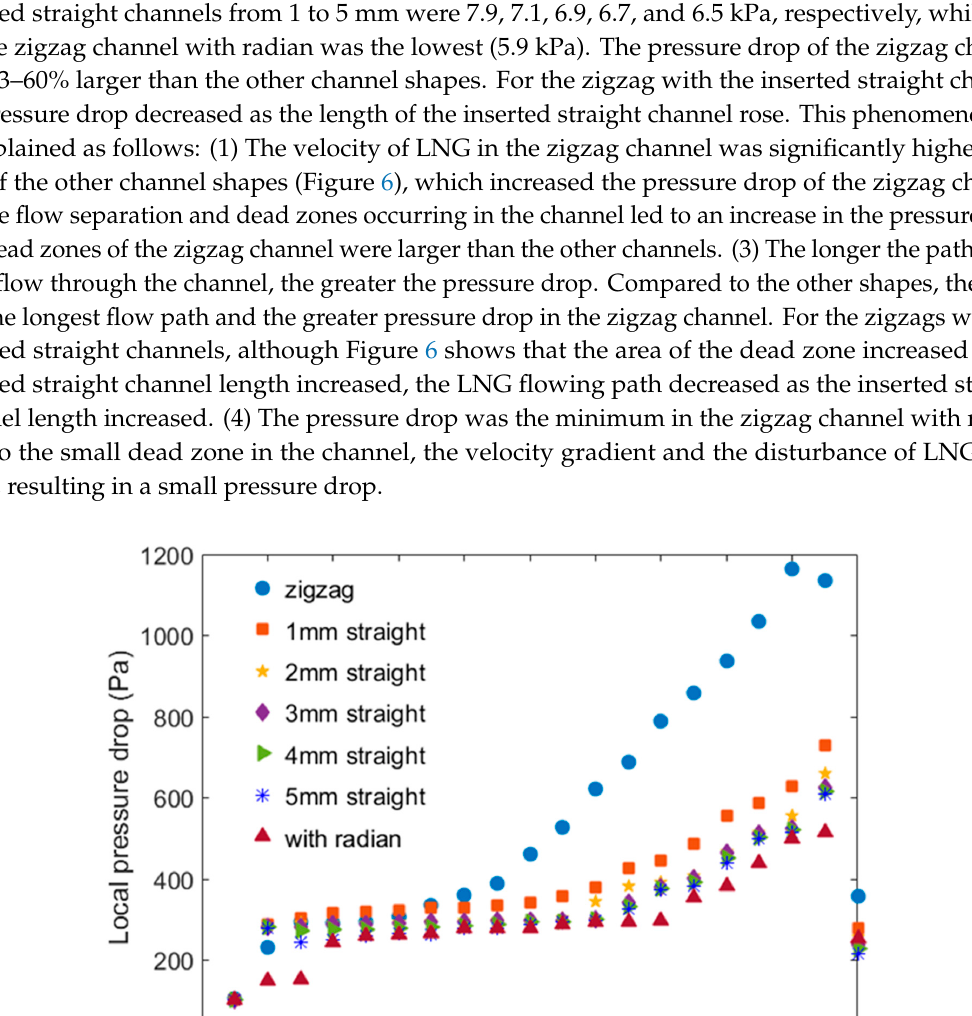
Table 2. Comparison between simulation and experimental results at 10 MPa: relative error.